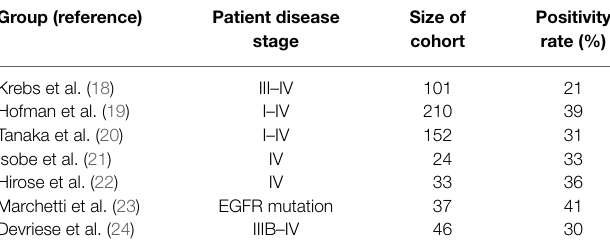
TABLE 1 | CTC detection in patients with NSCLC using EpCAM-dependent assays. Group (reference)